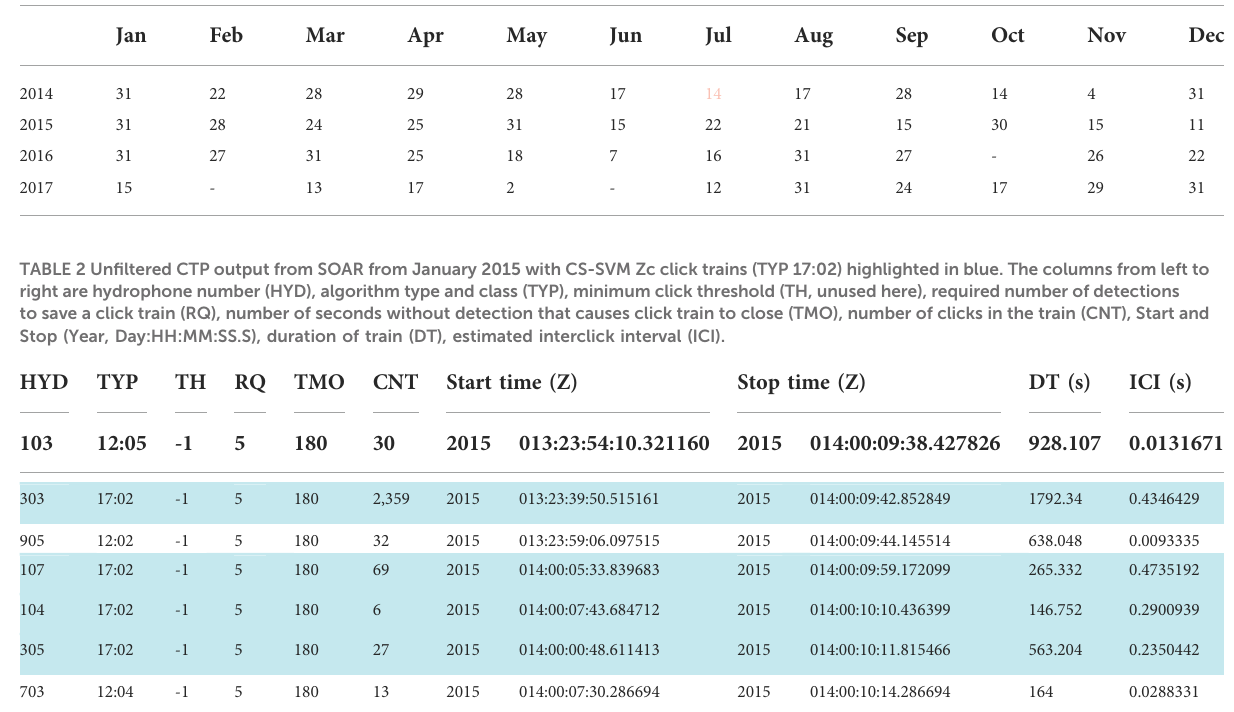
TABLE1ThenumberofdayspermonthduringwhichM3RarchivescontainingCS-SVMclassi fi eroutputwerecollectedatSOAR.TheCS-SVMbeaked whale buzz click classi fi er was installed in July, 2014 (pink).